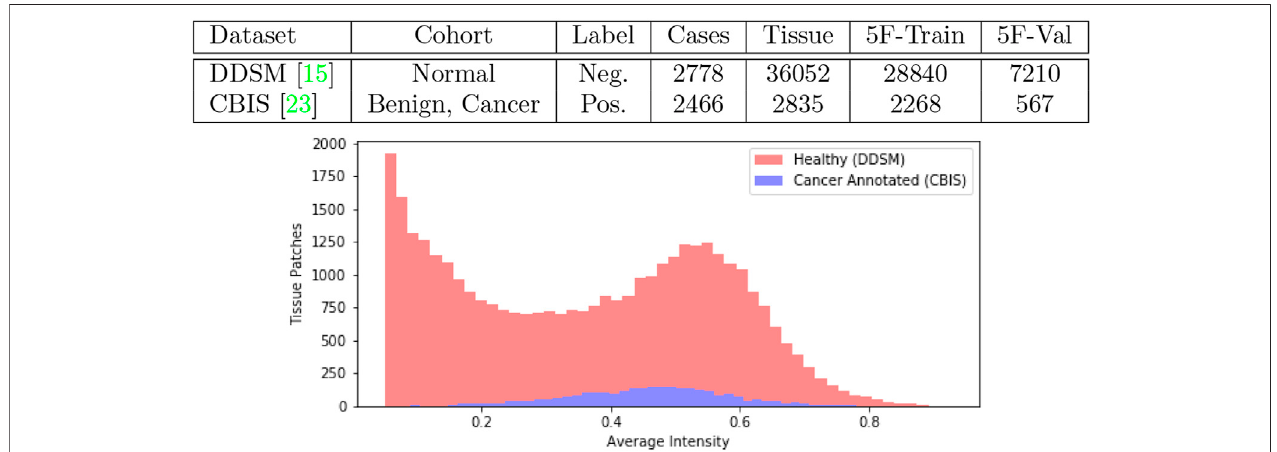
FIGURE 1 | Joint DDSM-CBIS Dataset. We gather positive and negative cases of cancerous tissue from DDSM (Heath et al., 1998), the largest publicly available source of mammogram data, and CBIS-DDSM (Lee et al., 2006) which improves the accuracy ofannotations in the original dataset. In total, we sample 38,887 patches of tissue from the mammograms. We ensure that both datasets are calibrated identically and organized into 5-Folds (5F).